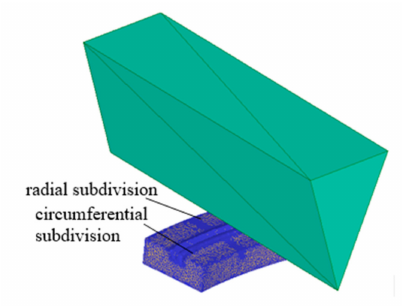
Figure 4. Finite element (FE) mesh model of the workpiece.